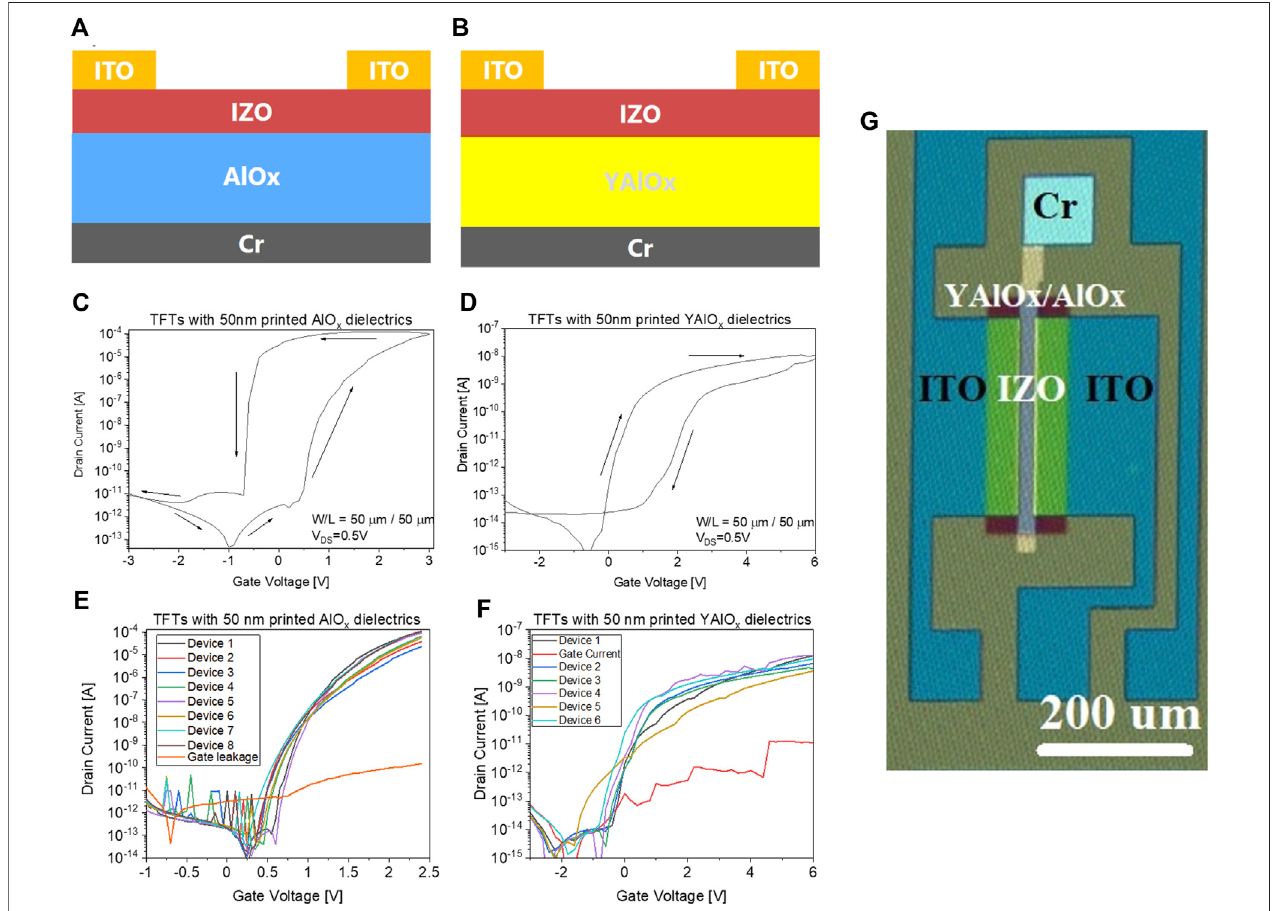
FIGURE 1 | (A) Schematic of the TFTs with AlO x only dielectrics. (B) Schematic of the TFTs with YAlO x only dielectrics. (C,D) Full sweep of the gate bias in the transfer characteristics resulting in the opposite direction of hysteresis. (E,F) Transfer characteristics of several TFTs (G) Optical microscope image of a fabricated TFT.